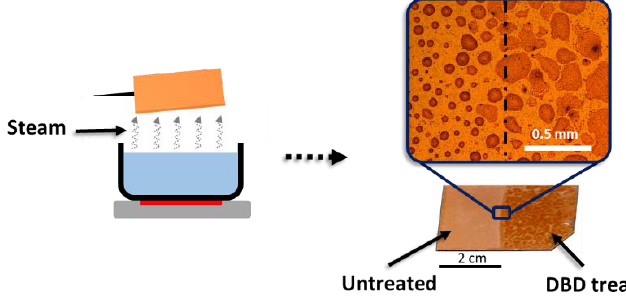
Figure 8. Condensation of water on plasma-treated and untreated Kapton.